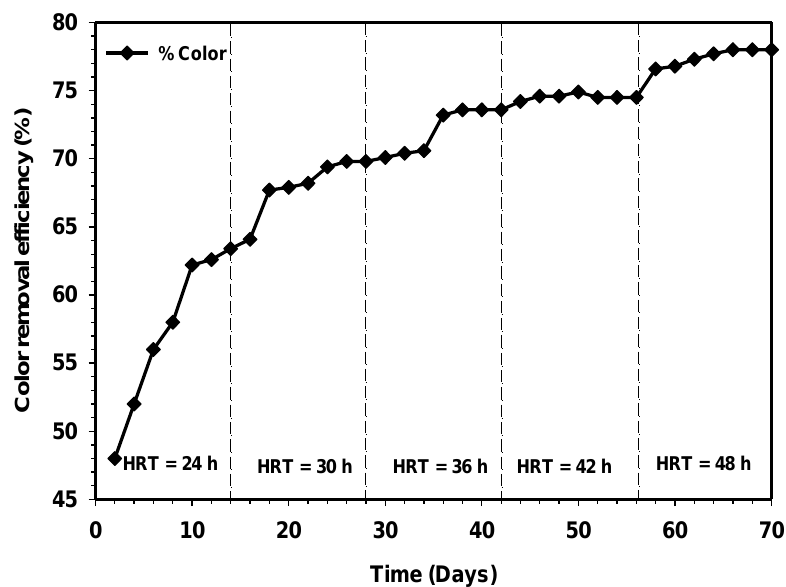
Figure 12. Variation of color removal relative to increasing contact time.